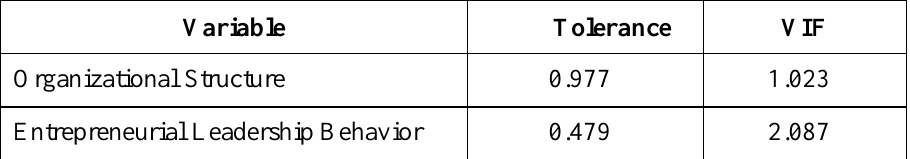
Table 07: Multicollinearity Test of the predictors of the study